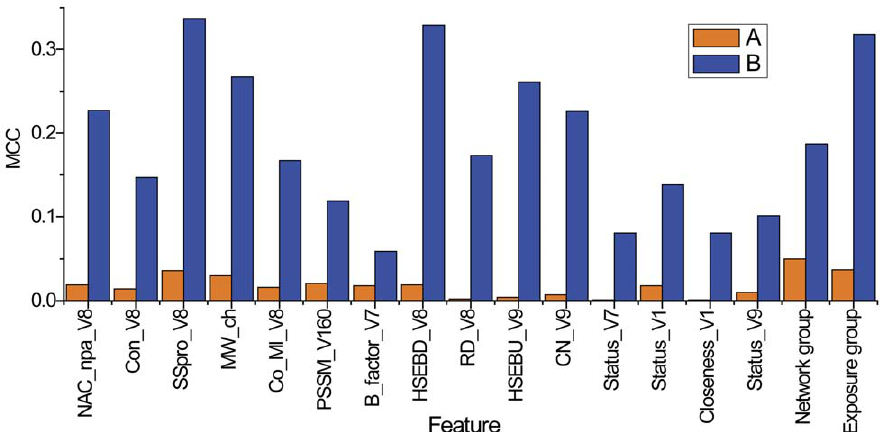
Figure 4. Effect of the removal or inclusion of the 15 individual optimal features on the prediction performance of the first-stage FunSAV classifier. Performance was evaluated using MCC. A: Performance of the trained classifier using the individual feature; B: MCC decrease of the trained classifier by removal of the corresponding feature. See Table 2 for more details about feature abbreviations.